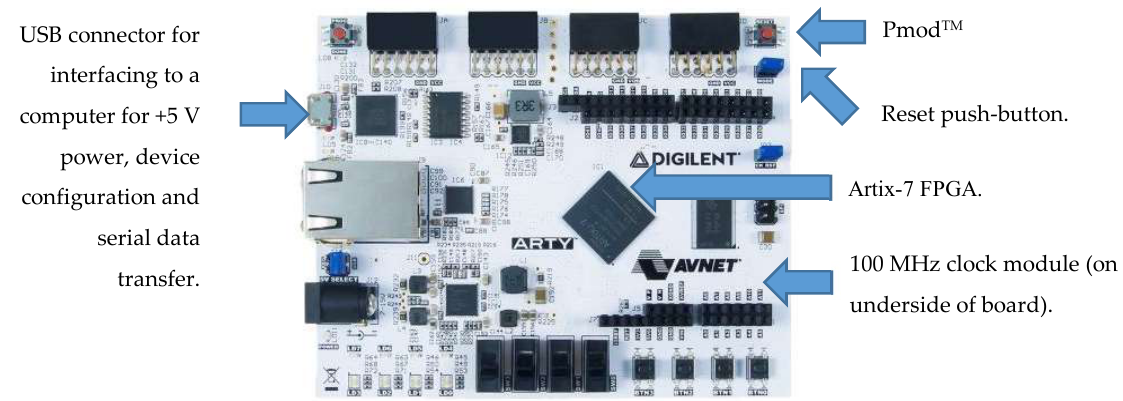
Figure 8. Xilinx ® Artix-7 FPGA on the Digilent ® Arty board identifying key components used in the experimentation.